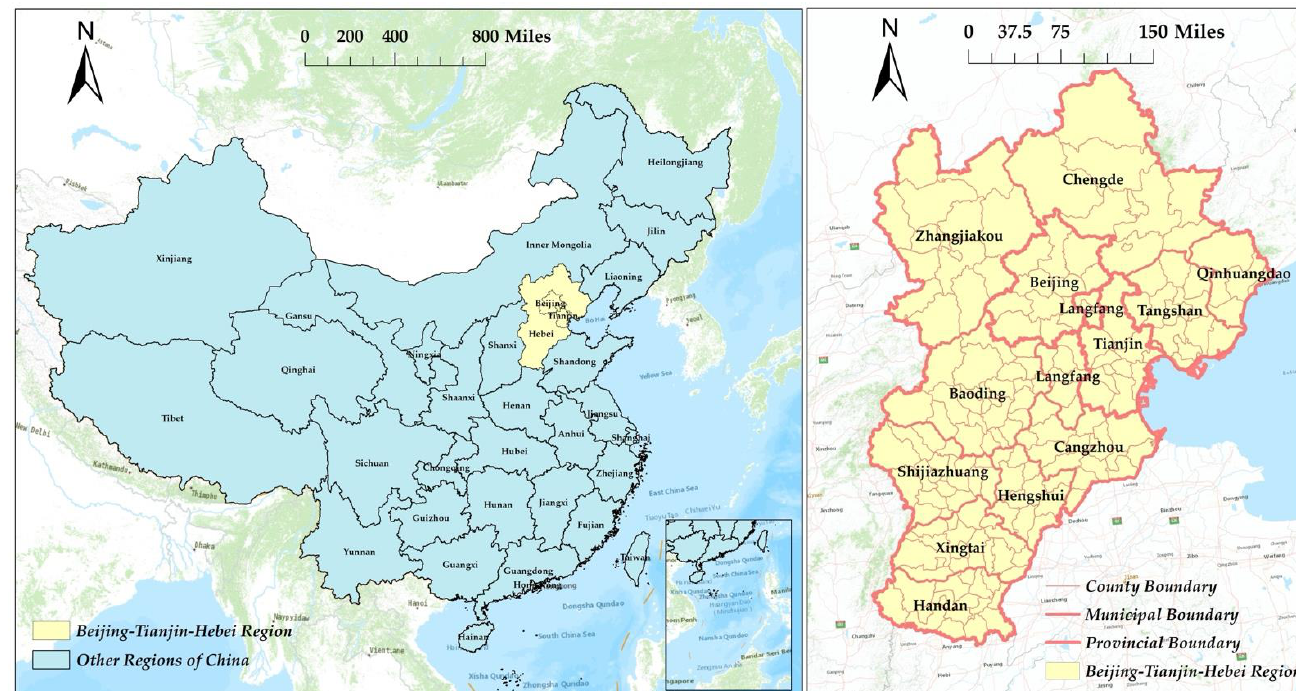
Figure 1. Location and range of the Beijing – Tianjin – Hebei region, China. Table 1. Phenomena revealed by different bands of Landsat